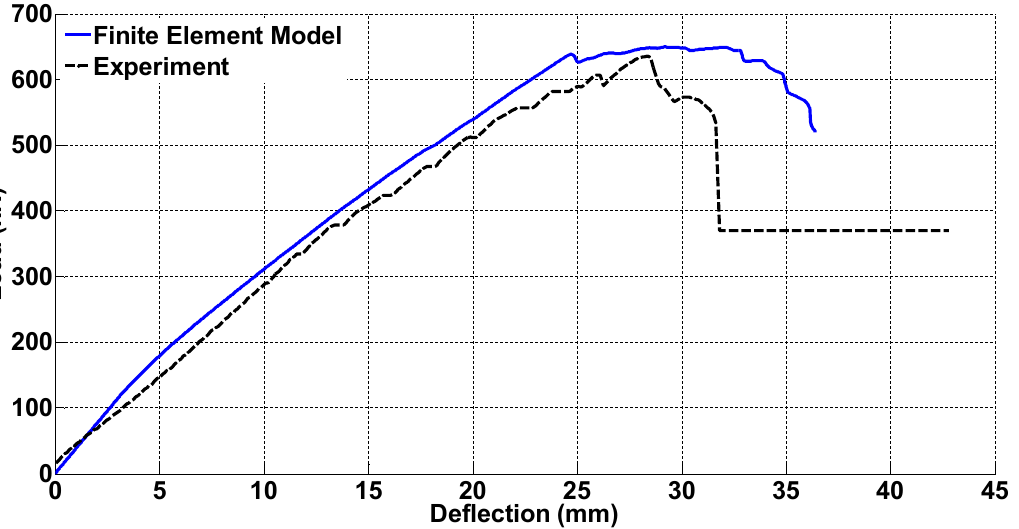
Figure 12. Crack patterns of the ( a ) FEM and the ( b ) experiment at peak load.